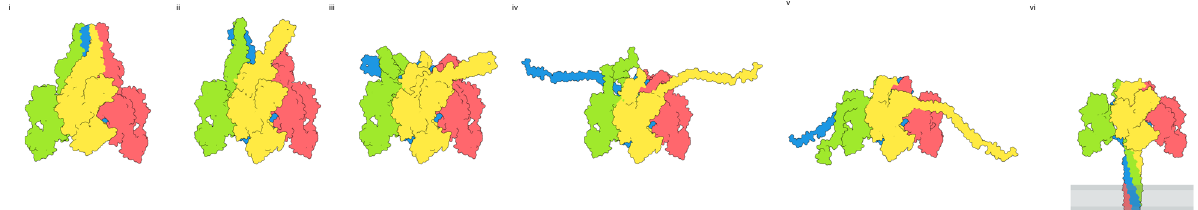
Fig. 5 Proposed model of Vip3Bc1 conformational rearrangement upon processing. Cleavage at K205 liberates helices α 1- α 4 allowing dissociation of inter-subunit interactions at the tip of the complex (i), the helices of domains 2 that are C-terminal to the cut site (from α 5 onwards), remain in essentially their original position stabilising the central interface of the tetramer. The α 4 helices form a central helical bundle while the other helices N-terminal to the cut site ( α 1-3) are able to unfurl and move down between the propeller domains to form a new helical bundle (ii – v), which interacts with the membrane via the ends of the helical